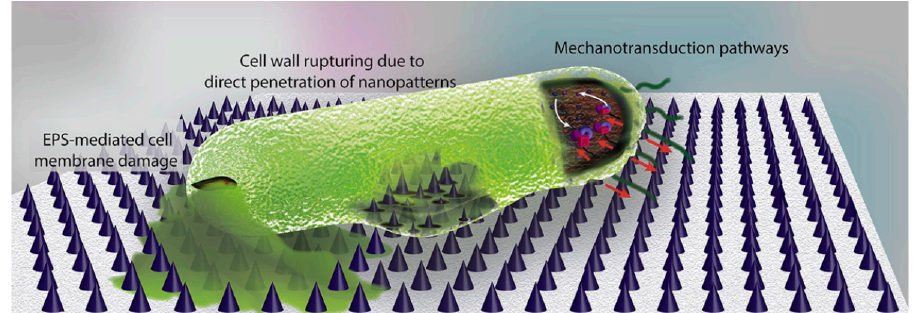
Figure 11. Illustration of the main bactericidal mechanisms of nanopatterns, as described in Refer- ence [150]. While the commonly believed theory is that bacterial cell wall is ruptured by penetration of high aspect ratio nanopatterns, a few studies suggest that EPS plays a key role. It has been shown that the strong attachment of EPS to the nanopatterns and the attempts of bacteria to move away from the unfavorable surface leads to cell membrane damage. Moreover, mechanotransduction pathways in which the mechanical forces affect the metabolomics, and the genomics of bacteria could be possible mechanisms of bacteria death on the surface. (Figure and Figure caption reproduced with permission from Reference